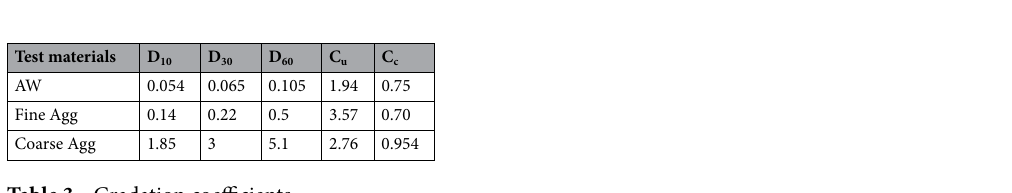
Table 3. Gradation coefficients.